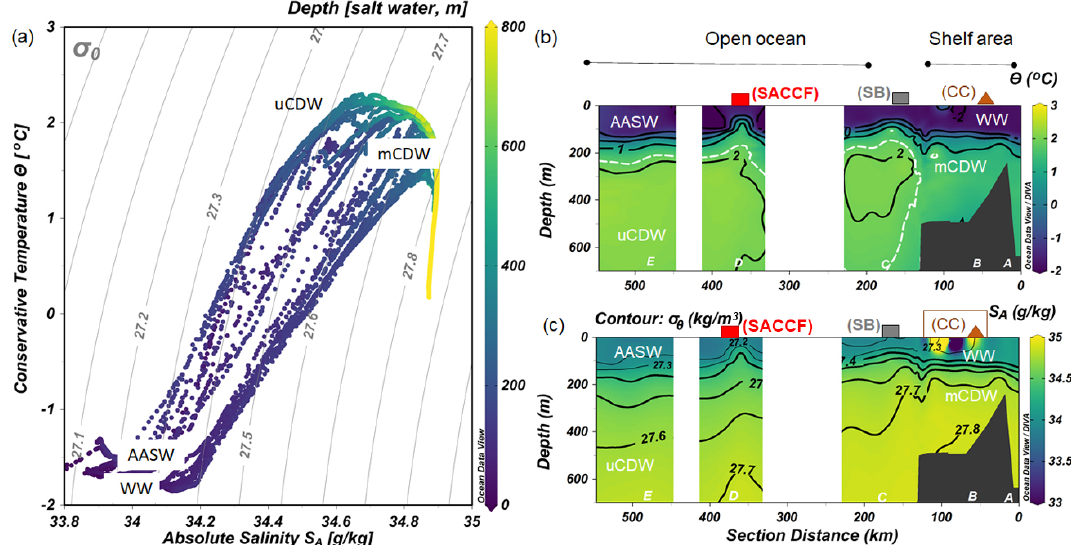
Figure 2. (a) Diagram of absolute salinity ( S A ) versus conservative temperature ( (cid:50) ) with isopycnal lines and colors denoting depth in meters. The distribution along the transect shown in Fig. 1 of (b) (cid:50) and (c) S A with density ( σ θ ) as contours. The approximate boundary between uCDW and mCDW is marked with a dashed white line in (b) . The values of (cid:50) and S A were generated by ODV software from CTD